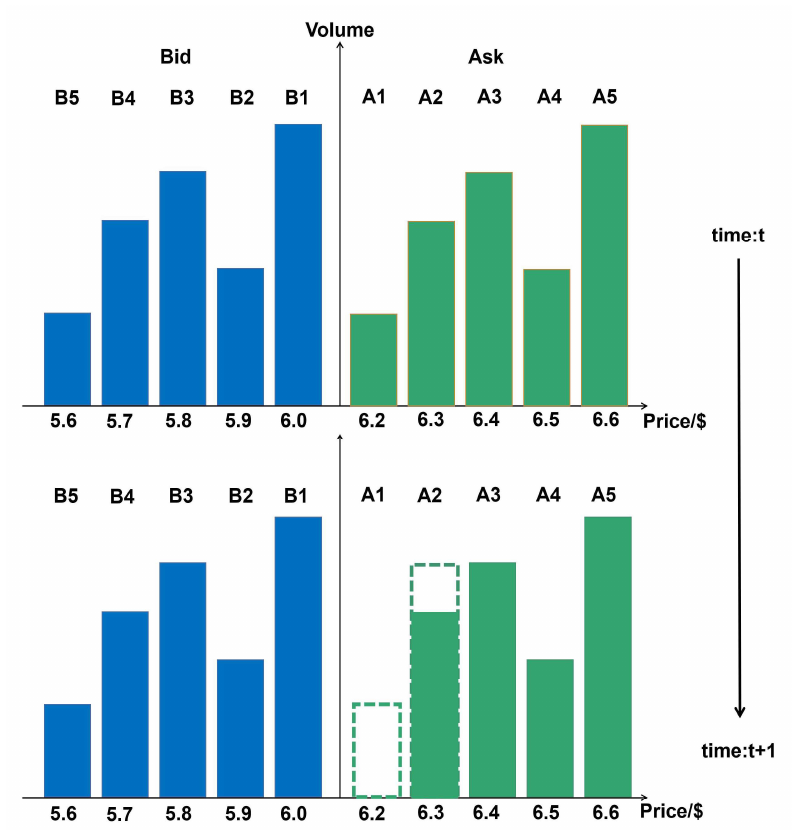
Figure 5. Snapshot of limit order book at time step t and t + 1. The above plot shows the best five prices of bid and ask and their corresponding volumes. Between time t and t + 1, the volumes on price 6.2 are traded or canceled, and some extra ask volumes are ordered on price